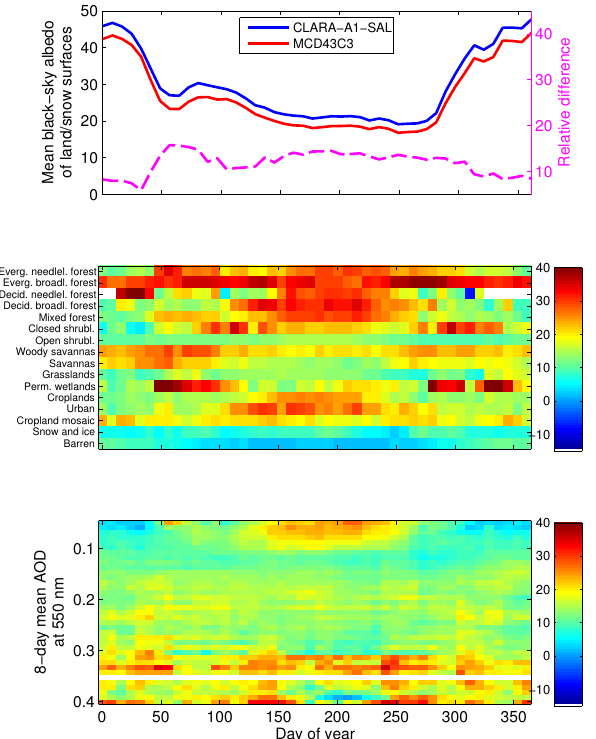
Fig. 9. (a) : CLARA-SAL and MCD43C3 mean retrievable black- sky albedo (in %, left axis) and relative difference (in %, right axis) over land/snow surfaces through 2009. (b) : Relative median differ- ence (CLARA-SAL minus MCD43C3) of products as a function of land use class and time through 2009, only land/snow surfaces considered. (c) : Relative median difference (CLARA-SAL minus MCD43C3) of products as a function of aerosol optical depth and time through 2009. Only land/snow surfaces considered in all plots. White color in subplots (b) and (c) marks no